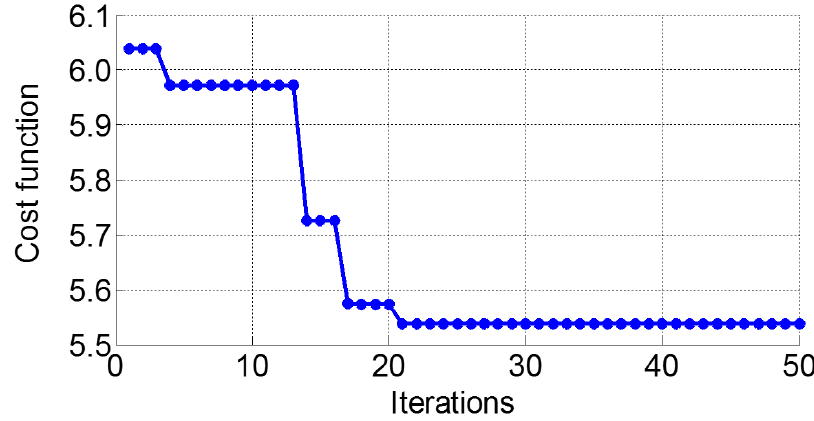
Figure 3. The iterative process of the PSO